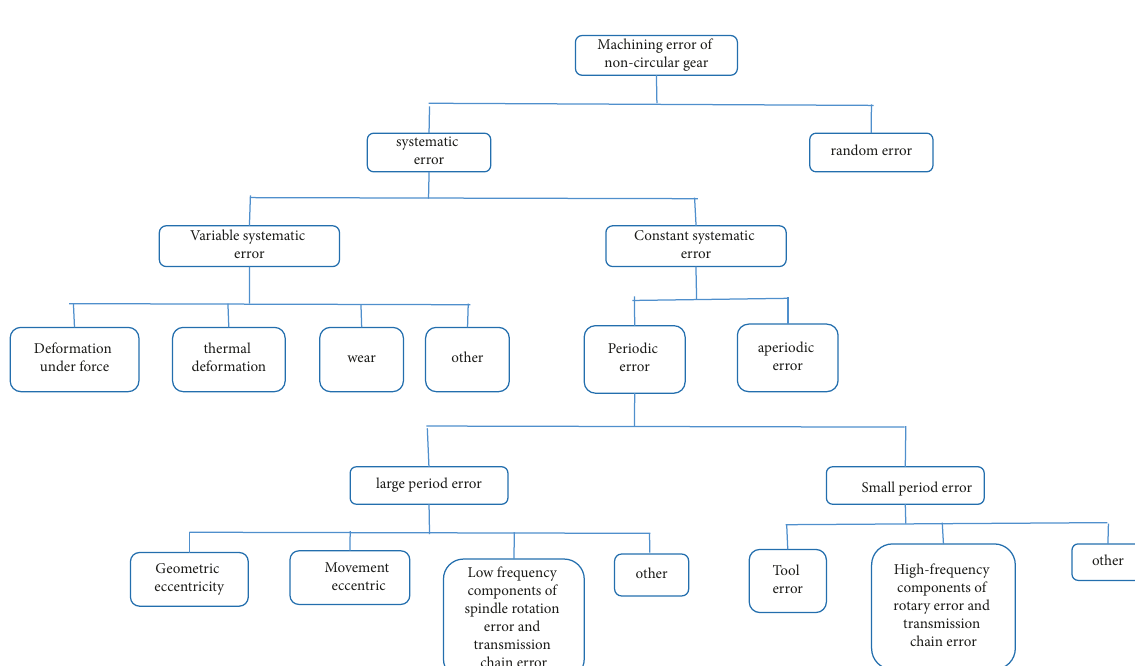
Figure 2: Classification diagram according to the manifestation of noncircular gear machining error.